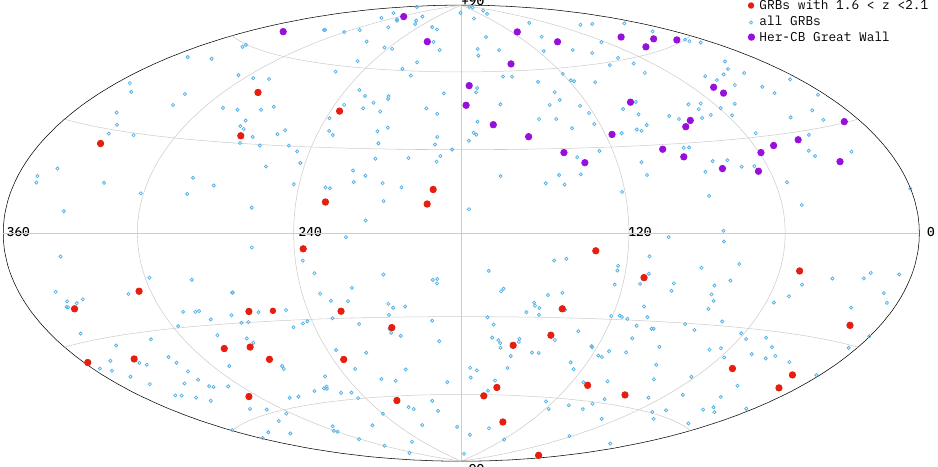
Figure 3. The distribution of GRBs in the redshift range of 1.6 < z ≤ 2.1, using current data. The Hercules-Corona Borealis Great Wall’s GRBs [7] are highlighted in